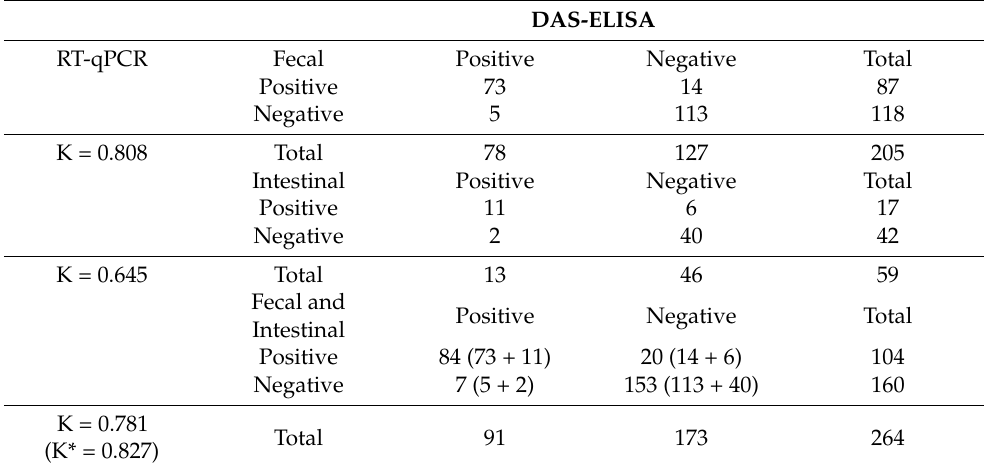
Table 1. The kappa values for calculating agreement between RT-qPCR and